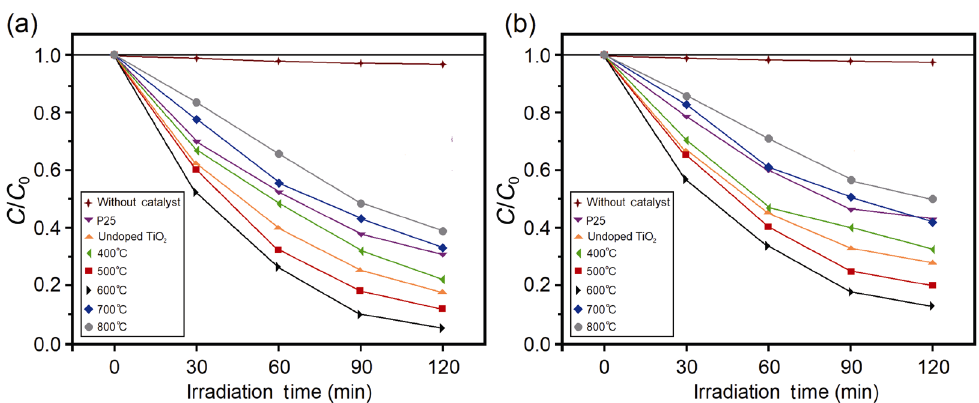
Fig. 6 Photocatalytic degradation of RhB solution without catalyst material and in presence of reference P25, undoped TiO 2 nanorod, and N–Fe codoped TiO 2 nanorods annealed at different temperatures under (a) UV light irradiation and (b) visible-light